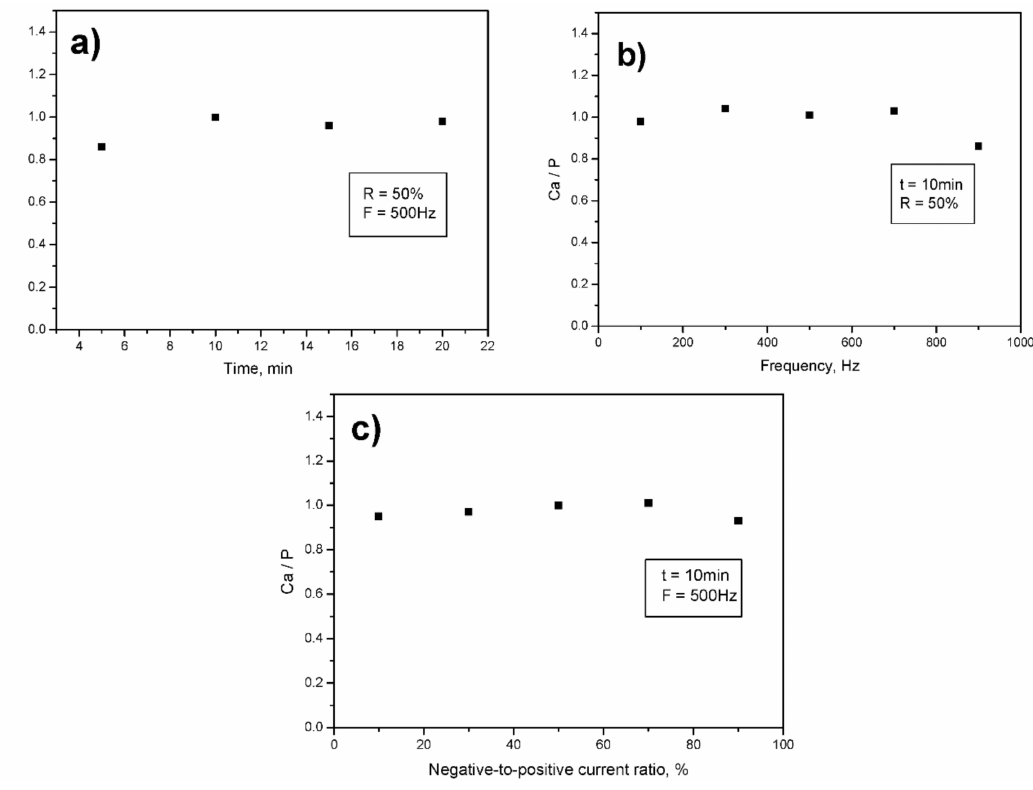
Figure 7. Variation of Ca/P ratio in the coating as a function of electrolysis time ( a ); frequency ( b ) and negative-to-positive current ratio, R ( c